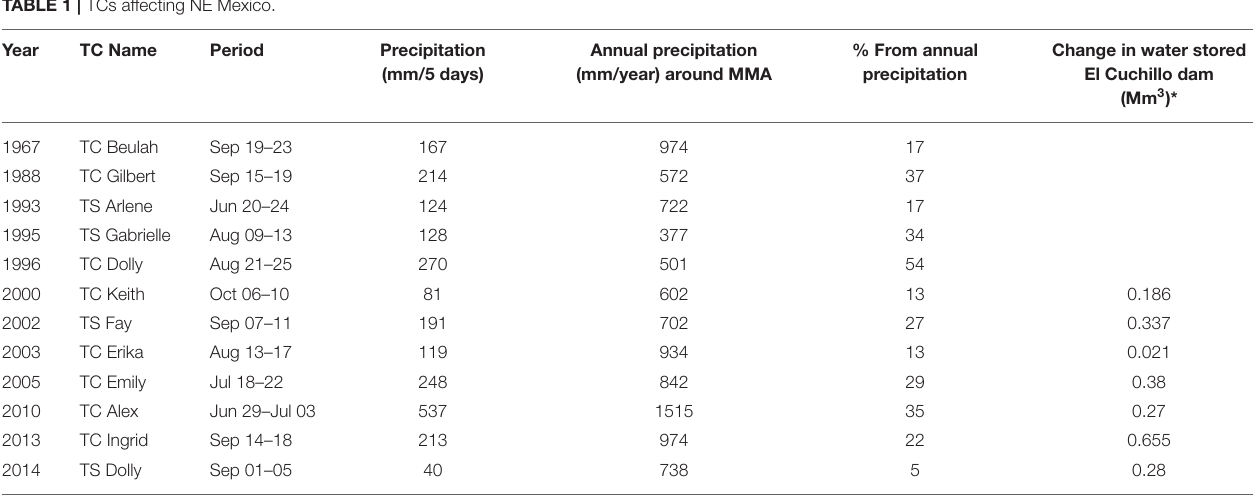
TABLE 1 | TCs affecting NE